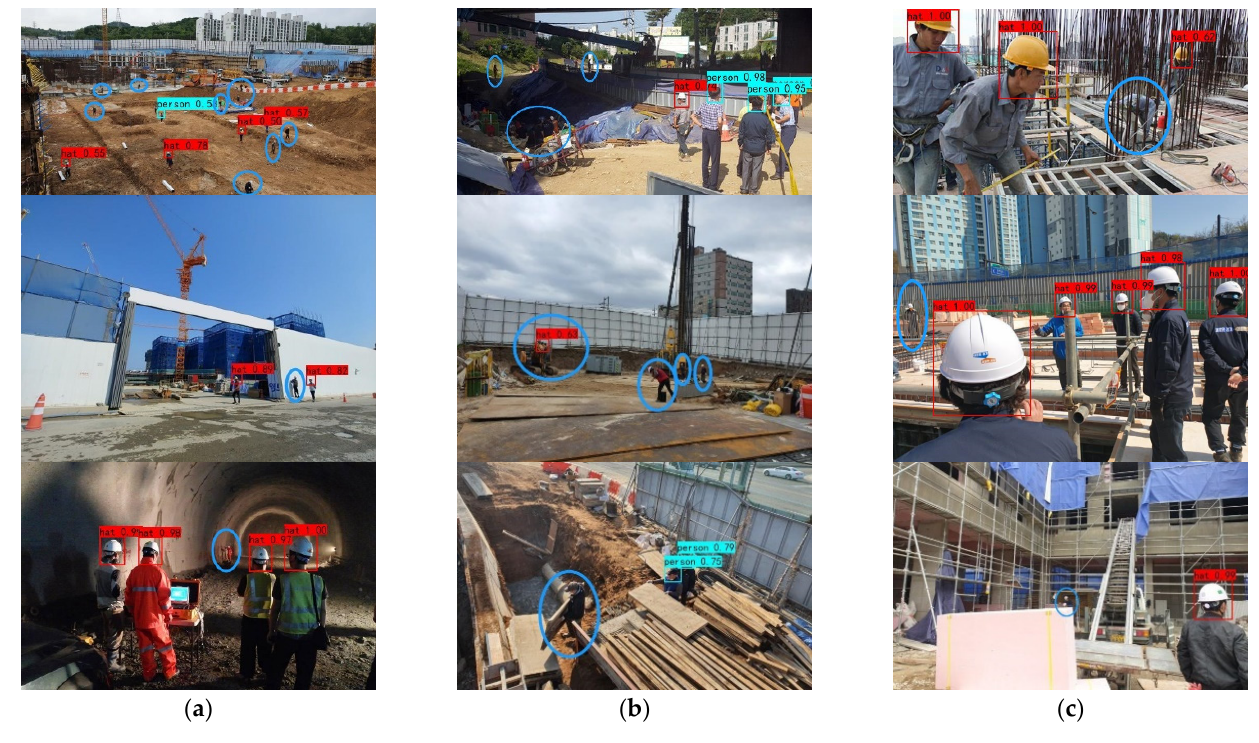
Figure 14. Limitations of the proposed method (blue circles represent false or missed objects), covering objects including ( a ) tiny objects, ( b ) severely under-illuminated or individual poses, and ( c ) obscured.